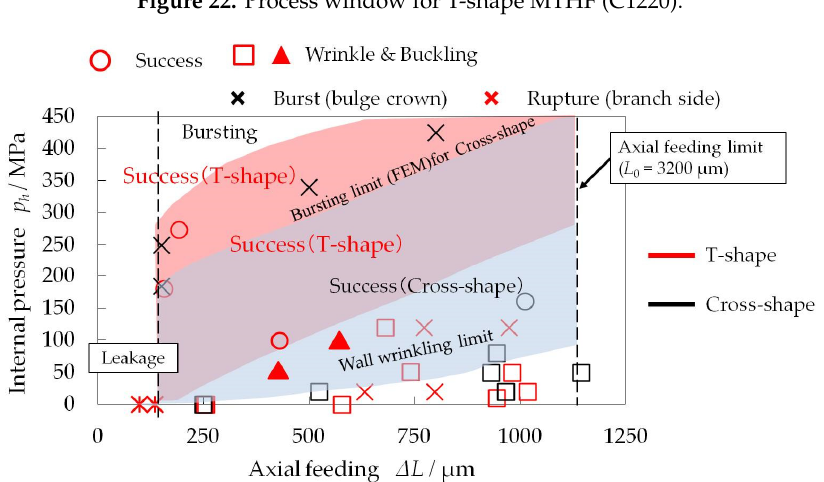
Figure 23. Process windows for T ‐ shape MTHF with results of cross ‐ shape MTHF plotted for comparison (C1220).